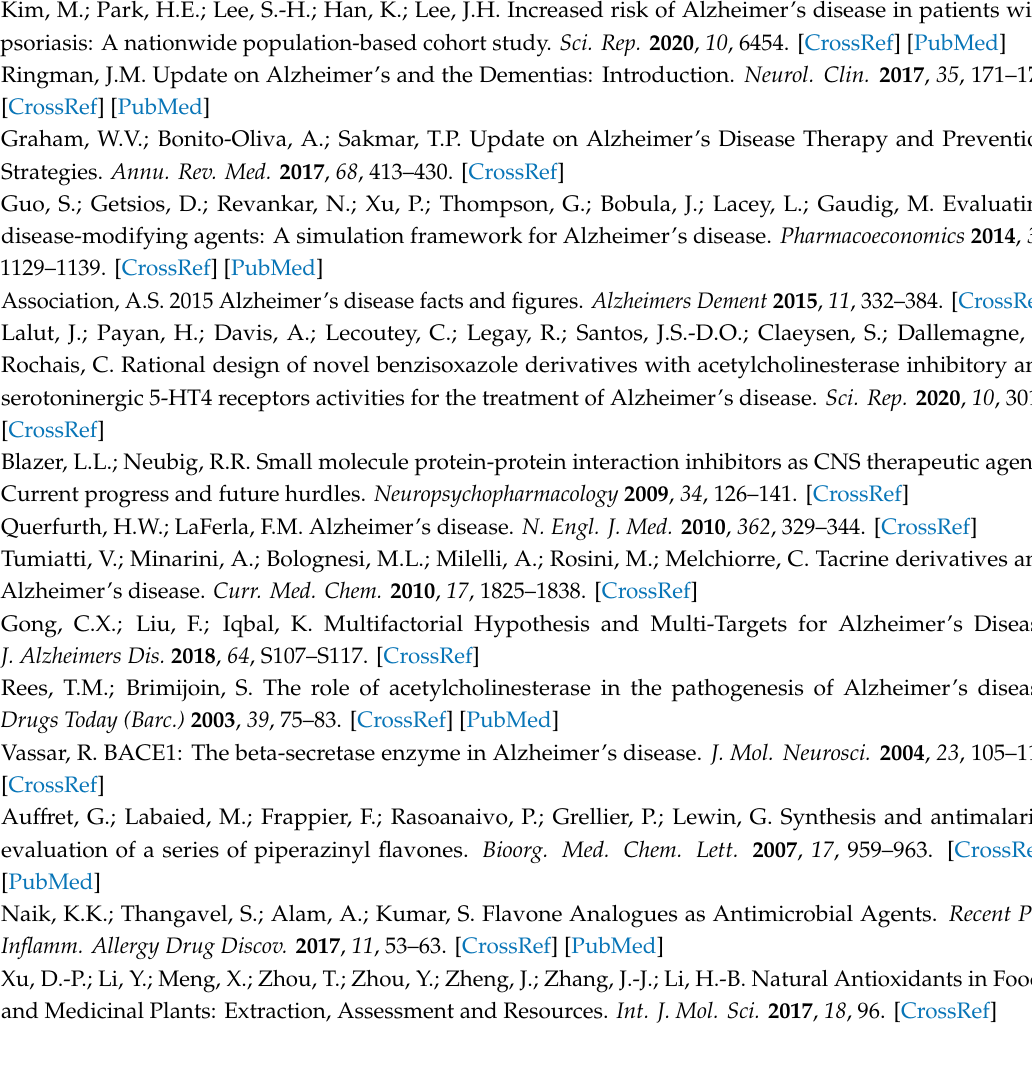
Table S1: Selected descriptors used for building 2D-QSAR models reported in the previous published work, Table S2: Values of selected descriptors used in the prediction of pIC 50 of the synthesized flavone derivatives (AChE), Table S3: Values of selected descriptors used in the prediction of pIC 50 of the synthesized flavone derivatives (BACE-1), Table S4: Results of re-docking (RMSD in Å), Table S5: Docking results and ligand interactions (Co-crystallized 1DX6), Table S6: Docking results and ligand interactions (Co-crystallized 6EQM), Table S7: Spectra of the synthesized flavone